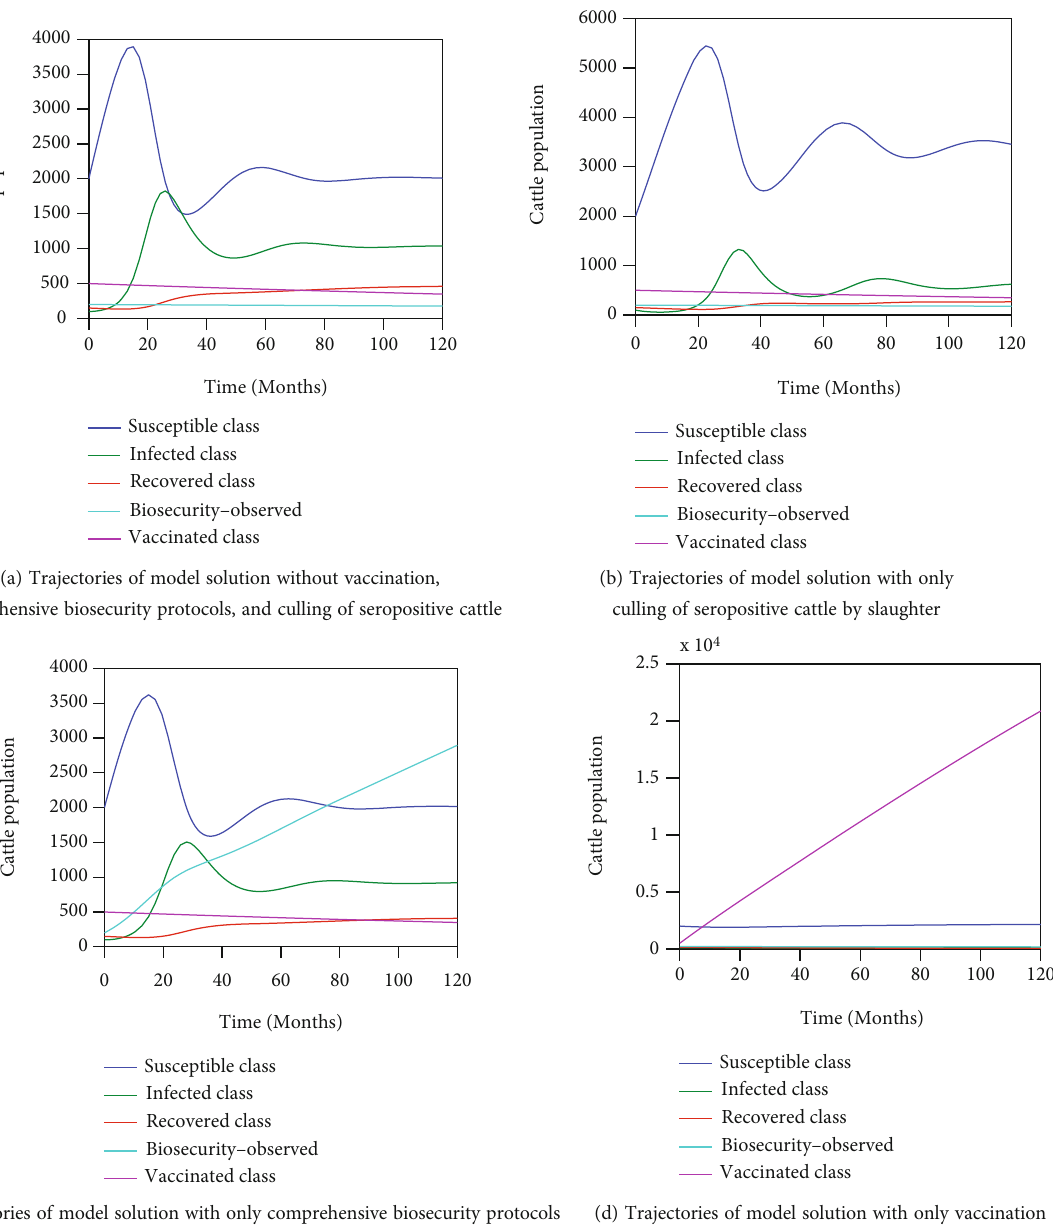
Figure 2: Trajectories of model solutions without any intervention and the implementation of single control